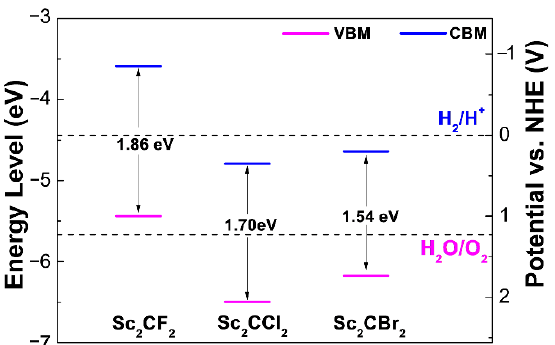
Figure 5. Band alignments with respect to the water reduction and oxidation potential levels of Sc 2 CT 2 MXenes.